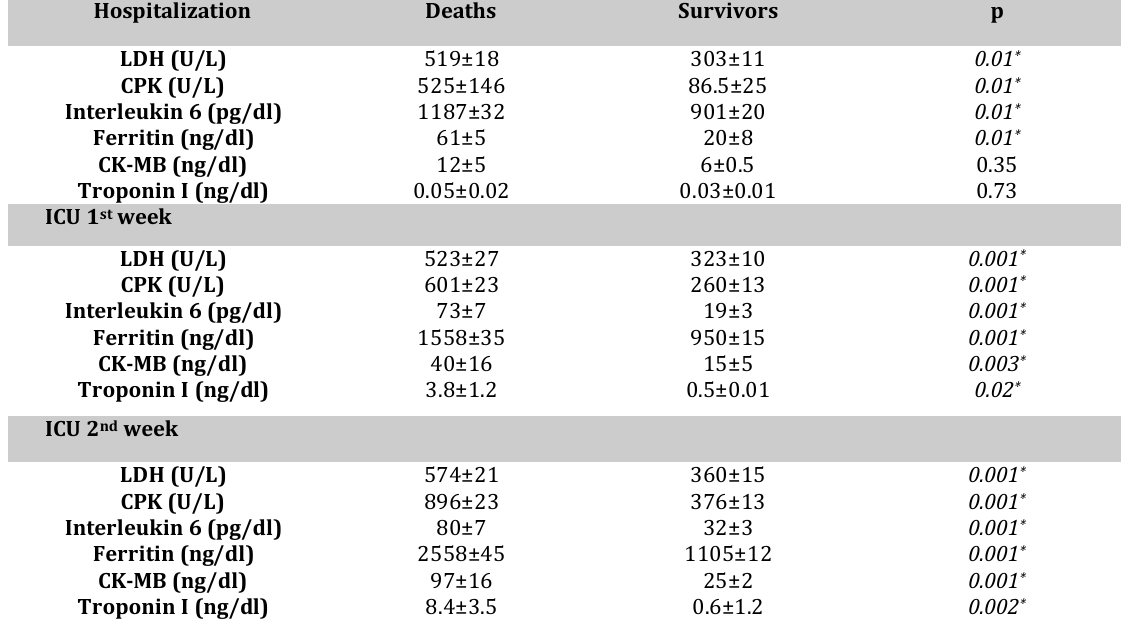
Table 2. Inflammatory and tissue damage Biomarkers Deaths and Survivors patients with Covid-19 disease.